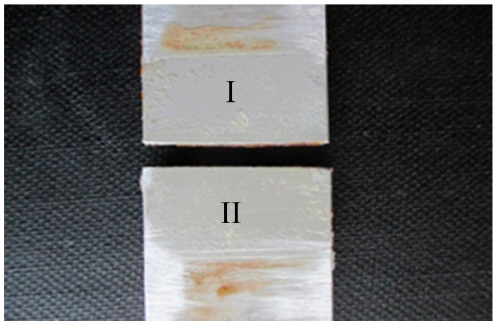
Figure 17. Aluminum–aluminum specimens after the shear strength test. (Specimen I and specimen II).